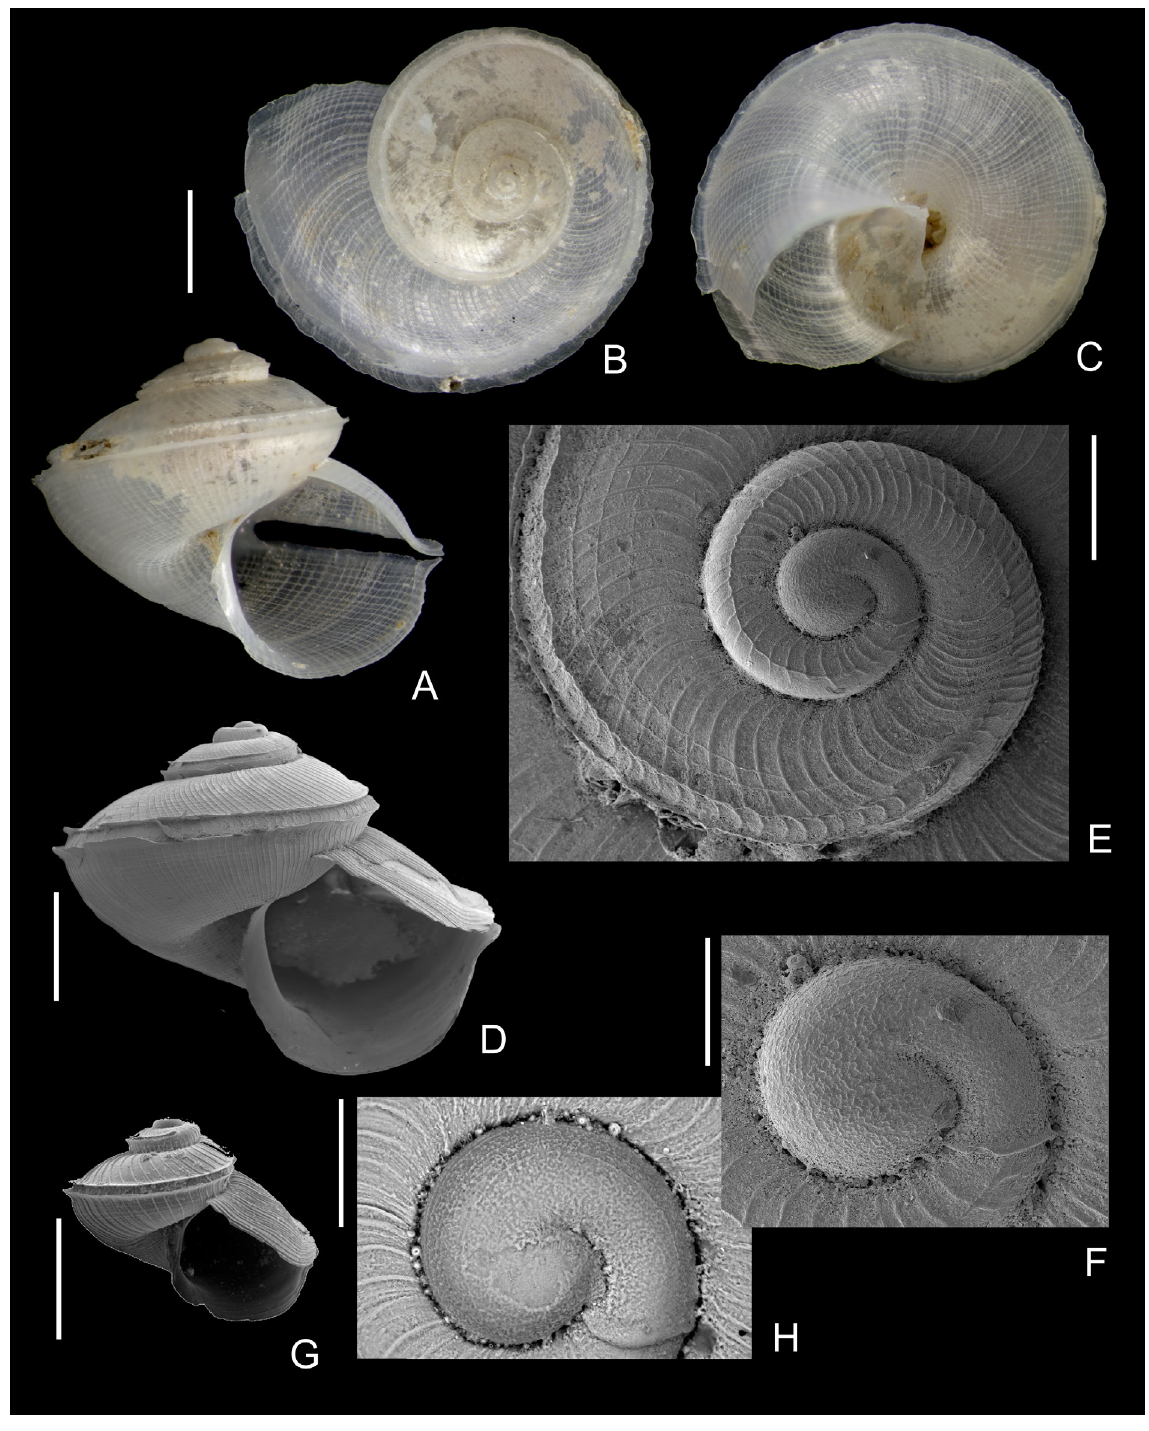
Fig. 10. Anatomidae 4. Anatoma corralae Gofas & Luque sp. nov. A–C . Paratype (MNCN 15.05/200138P), BANGAL 0711, V10, 1720 m, 4.0 mm diameter. D–F . Holotype (MNCN 15.05/200138H), SEM micrograph, BANGAL 0711, V10, 4.1 mm diameter. E–F . Details of early teleoconch whorls and protoconch of the holotype. G–H . Shell and detail of the protoconch, SEM micrographs, from BANGAL 0711, V5, 1631 m, 2.1 mm diameter. Scale bars: A–D, G = 1 mm; E = 200 µm; F, H = 100